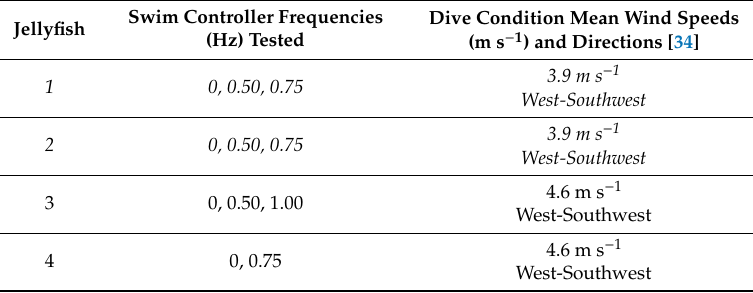
Table 1. Field test variables. Animals ( n = 4) and swim controller frequencies tested in situ. Italicized conditions were tested on the first day and used for quantitative analysis. Jellyfish